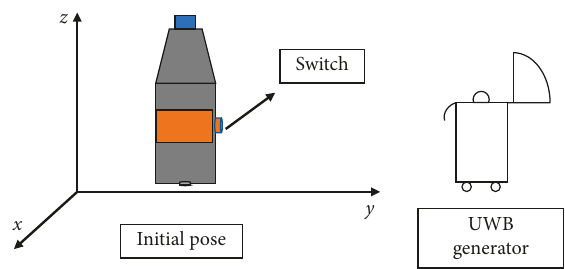
Figure 18: Initial pose of the detector.